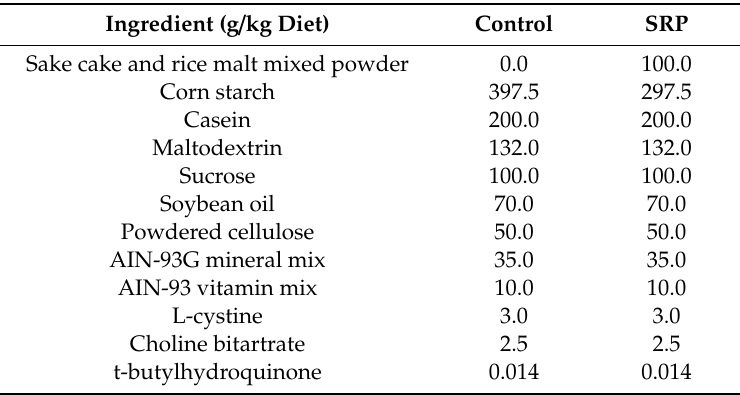
Table 2. Composition of the experimental